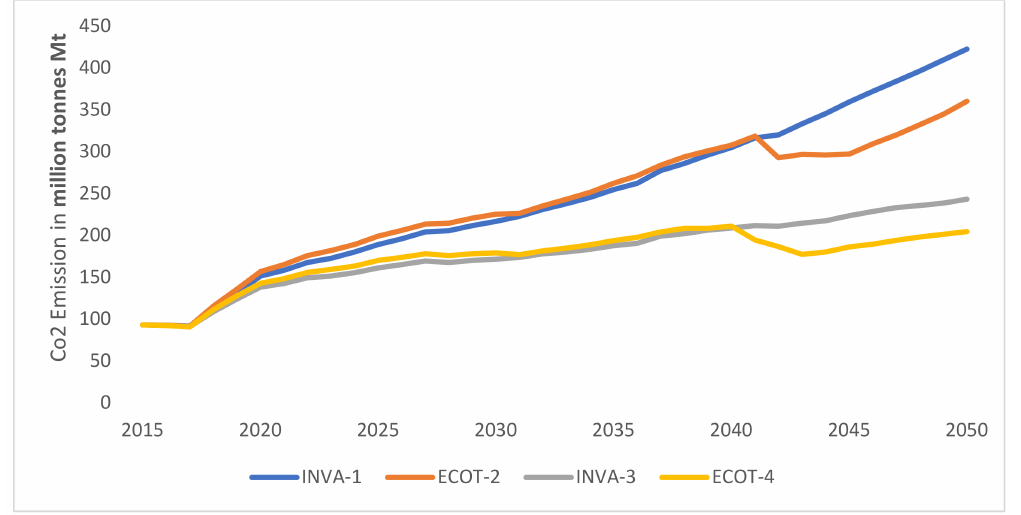
Figure 7. CO 2 emissions under renewable energy